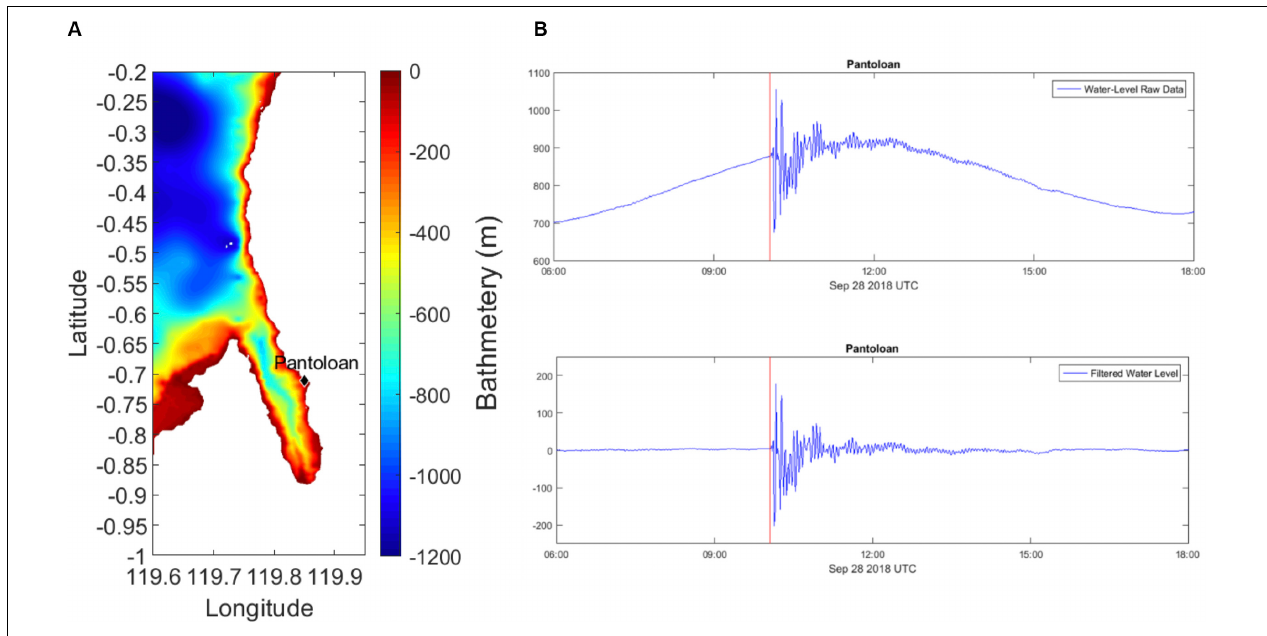
FIGURE 4 | (A) Location of Pantoloan and the computational domain of COMCOT. The color shading depicts the water depth in meters. The station of Pantoloan located at ( − 0.7120 ◦ E, 119.8554 ◦ N) is labeled by the solid black diamond. The bathymetry data is from the BATNAS data bank of Badan Informasi Geospasial (BIG), Indonesia. (B) Upper panel: the observed wave level at Pantoloan in cm; lower panel: the time series of tsunami signal at Pantoloan by Butterworth high-pass filter with the cutoff frequency of 6 h in cm. The red line indicates the time of the mainshock of the earthquake (10:02 UTC, September 28, 2018).